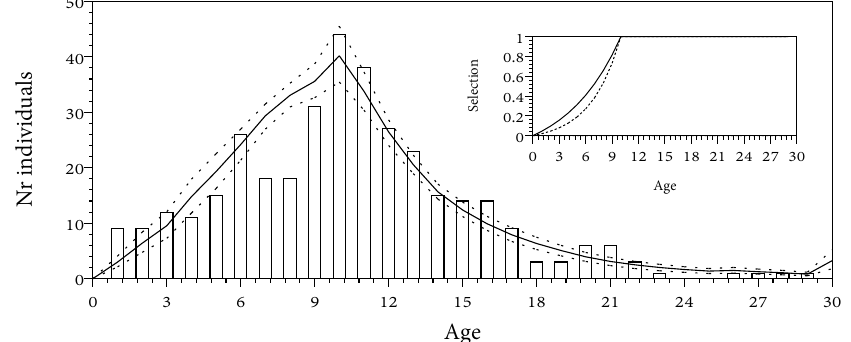
Fig. 2. Model fit to the age-structured data from the 1987 to 1991 harvest in the North Water, using the exponential model for Baffin Bay walruses (model eB). Data are given by bars, and the model by the median estimate (solid curve) and the 95% credibility interval (dashed curves). The insert shows the estimated median and credibility intervals of the age-structured harvest